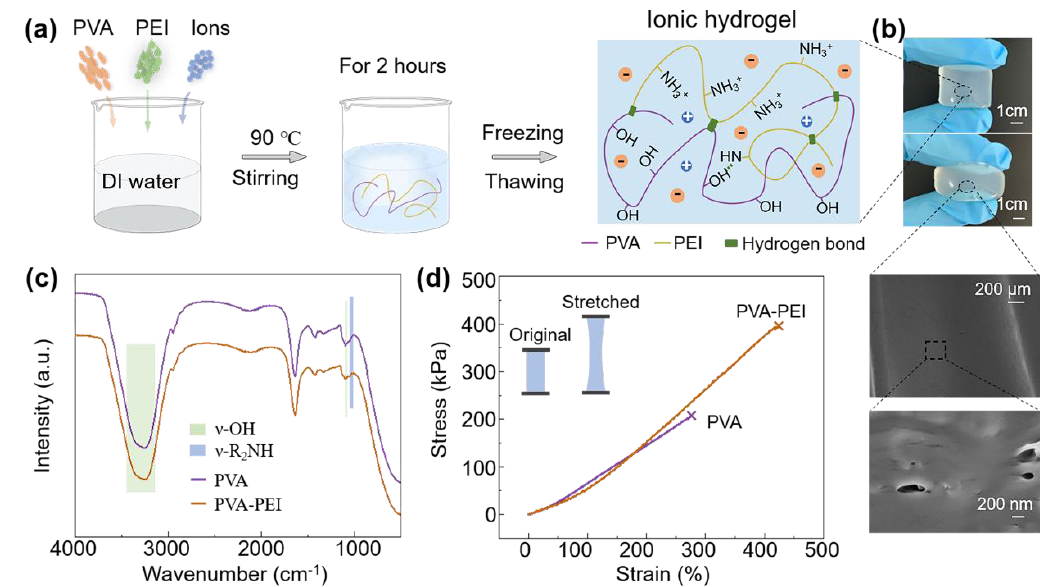
Figure 2. Schematic showing the fabrication process and the properties of the ionic hydrogel. ( a ) The preparation process and structure of the ionic hydrogel. ( b ) The as-fabricated hydrogel exhibited superior transparency and mechanical elasticity. The SEM images of the hydrogel showed a porous structure. ( c ) The Fourier transform infrared spectroscopy (FTIR) spectra of PVA-PEI-based ionic hydrogel. ( d ) The tensile stress – strain curves of PVA and PVA-PEI-based hydrogel.